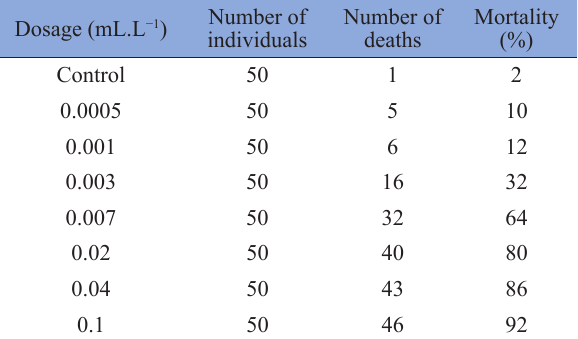
Table 2: Mortality of susceptible reference line exposed to Dosage (mL.L −1 )